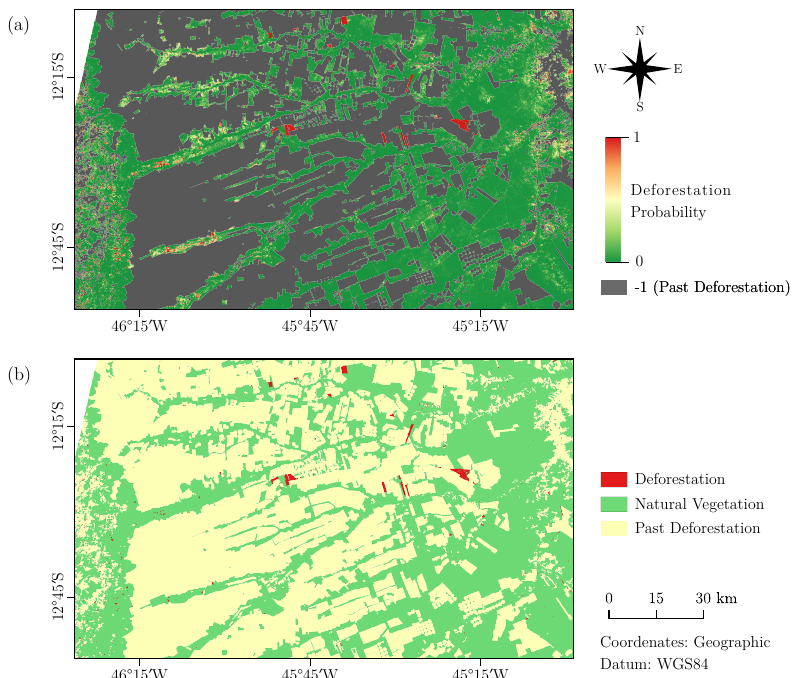
Figure 7. Results for Bahia study area using Landsat time series and training samples based on Approach 3. ( a ) LSTM deforestation probability map; ( b ) U-Net deforestation map.